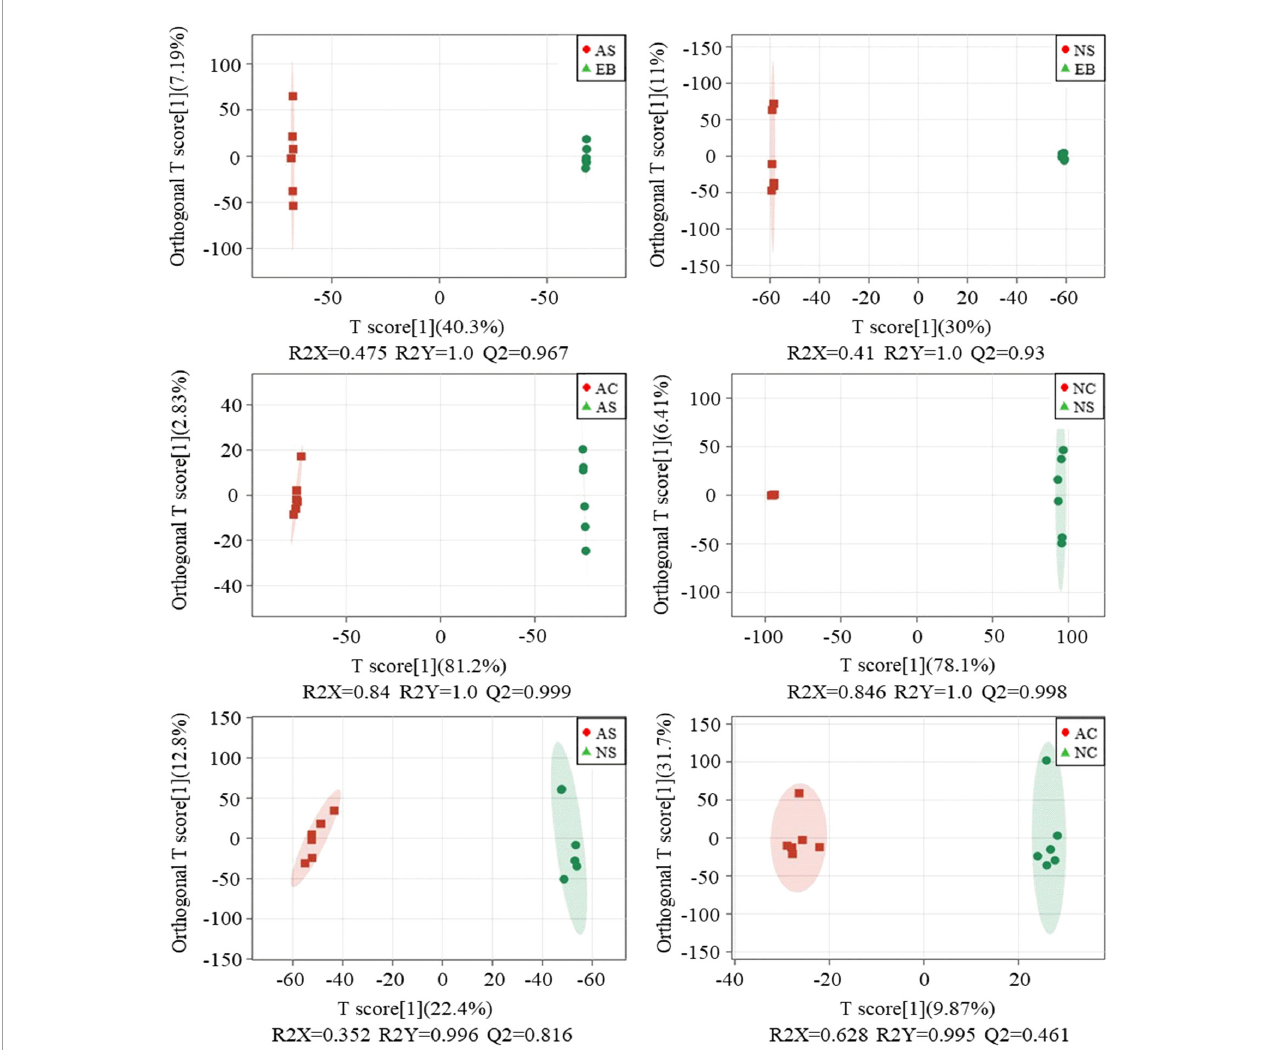
FIGURE4 OPLS-DA analysis of profiling data of Polygonati Rhizoma fermented using Lactiplantibacillus plantarum under aerobic and anaerobic conditions. AC, aerobic fermentation L. plantarum cells; NC, anaerobic fermentation L. plantarum cells; AS, aerobic fermentation supernatants; NS,